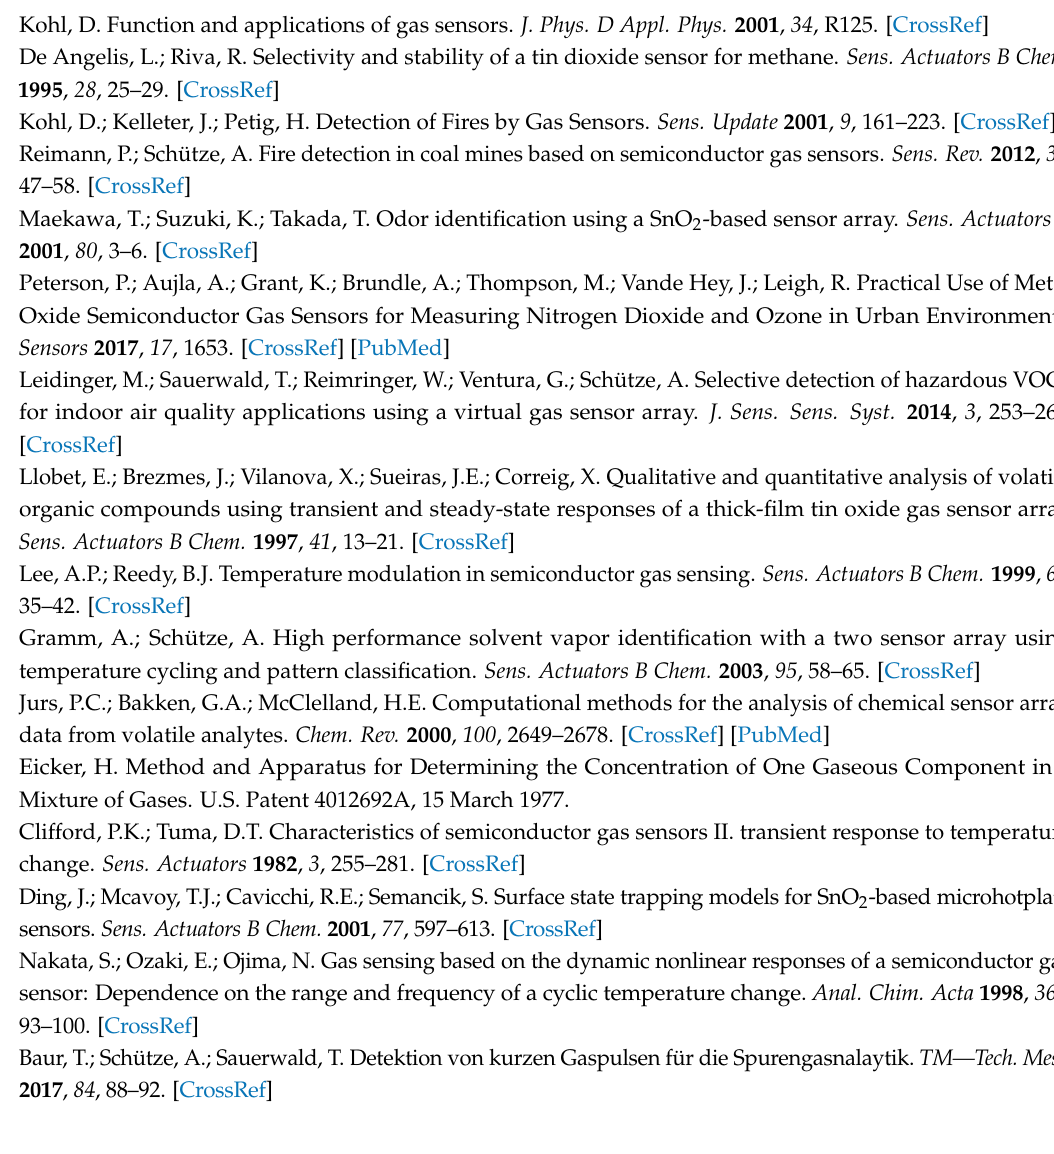
Figure S1: Heater temperature calculated from the heater resistance around the temperature step from 450 ◦ C to 150 ◦